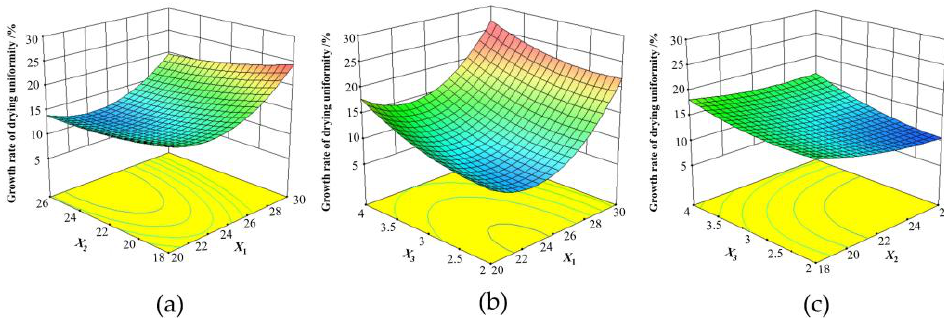
Figure 4. Growth rate of drying uniformity versus: ( a ) moisture content of Cyperus esculentus at the beginning of tempering and tempering temperature; ( b ) tempering duration and tempering temperature; ( c ) tempering duration and moisture content of Cyperus esculentus at the beginning of tempering.